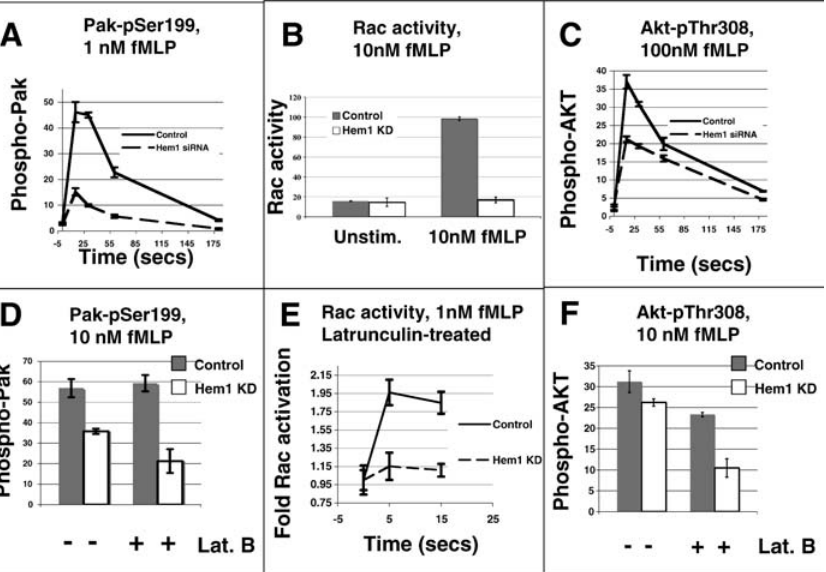
Figure 5. Rac Activation and PIP 3 Generation Are Dependent on Hem-1 Control or Hem-1 knockdown cells were stimulated in suspension with the indicated dose of agonist. TCA was used to stop the reaction (A, C, D, F) and precipitate proteins for immunoblotting or cells were lysed with NP-40, and Rac-GTP was captured with the Rac-binding domain of PAK (B, E). Western blots were quantitated using fluorescent secondary antibodies and the Odyssey system. The y-axis indicates integrated (background-subtracted) fluorescence of secondary antibody on blots in arbitrary units. All experiments were performed in triplicate and are shown with standard error of mean. (A) Effect of Hem-1 depletion on phosphorylation of PAK (readout of Rac activation) for cells treated with 1 nM fMLP. (B) Effect of Hem-1 depletion on Rac activation (assayed with PAK GBD pulldown) for cells treated with 10 nM fMLP for 15 s. (C) Effect of Hem-1 depletion on phosphorylation of Akt/PKB (readout of PIP 3 production) for cells stimulated with 100 nM fMLP. (D–F) Defects in PIP 3 generation and Rac activation are independent of actin polymerization. Results are shown with standard error for cells stimulated in triplicate at 37 8 C. (D) Cells were preincubated with 10 l M latrunculin B, stimulated with 10 nM fMLP for 30 s, and blotted with antibodies to PAK- phospho-Ser199. (E) Cells were preincubated with 10 l M latrunculin, stimulated with 1 nM fMLP for 15 s, lysed, and incubated with PAK-GBD (to capture Rac-GTP), and blotted for Rac. (F) Cells were preincubated with 10 l M latrunculin B, stimulated with 10 nM fMLP for 15 s, and then blotted with antibodies to Akt/PKB phospho-Thr308. DOI: 10.1371/journal.pbio.0040038.g005